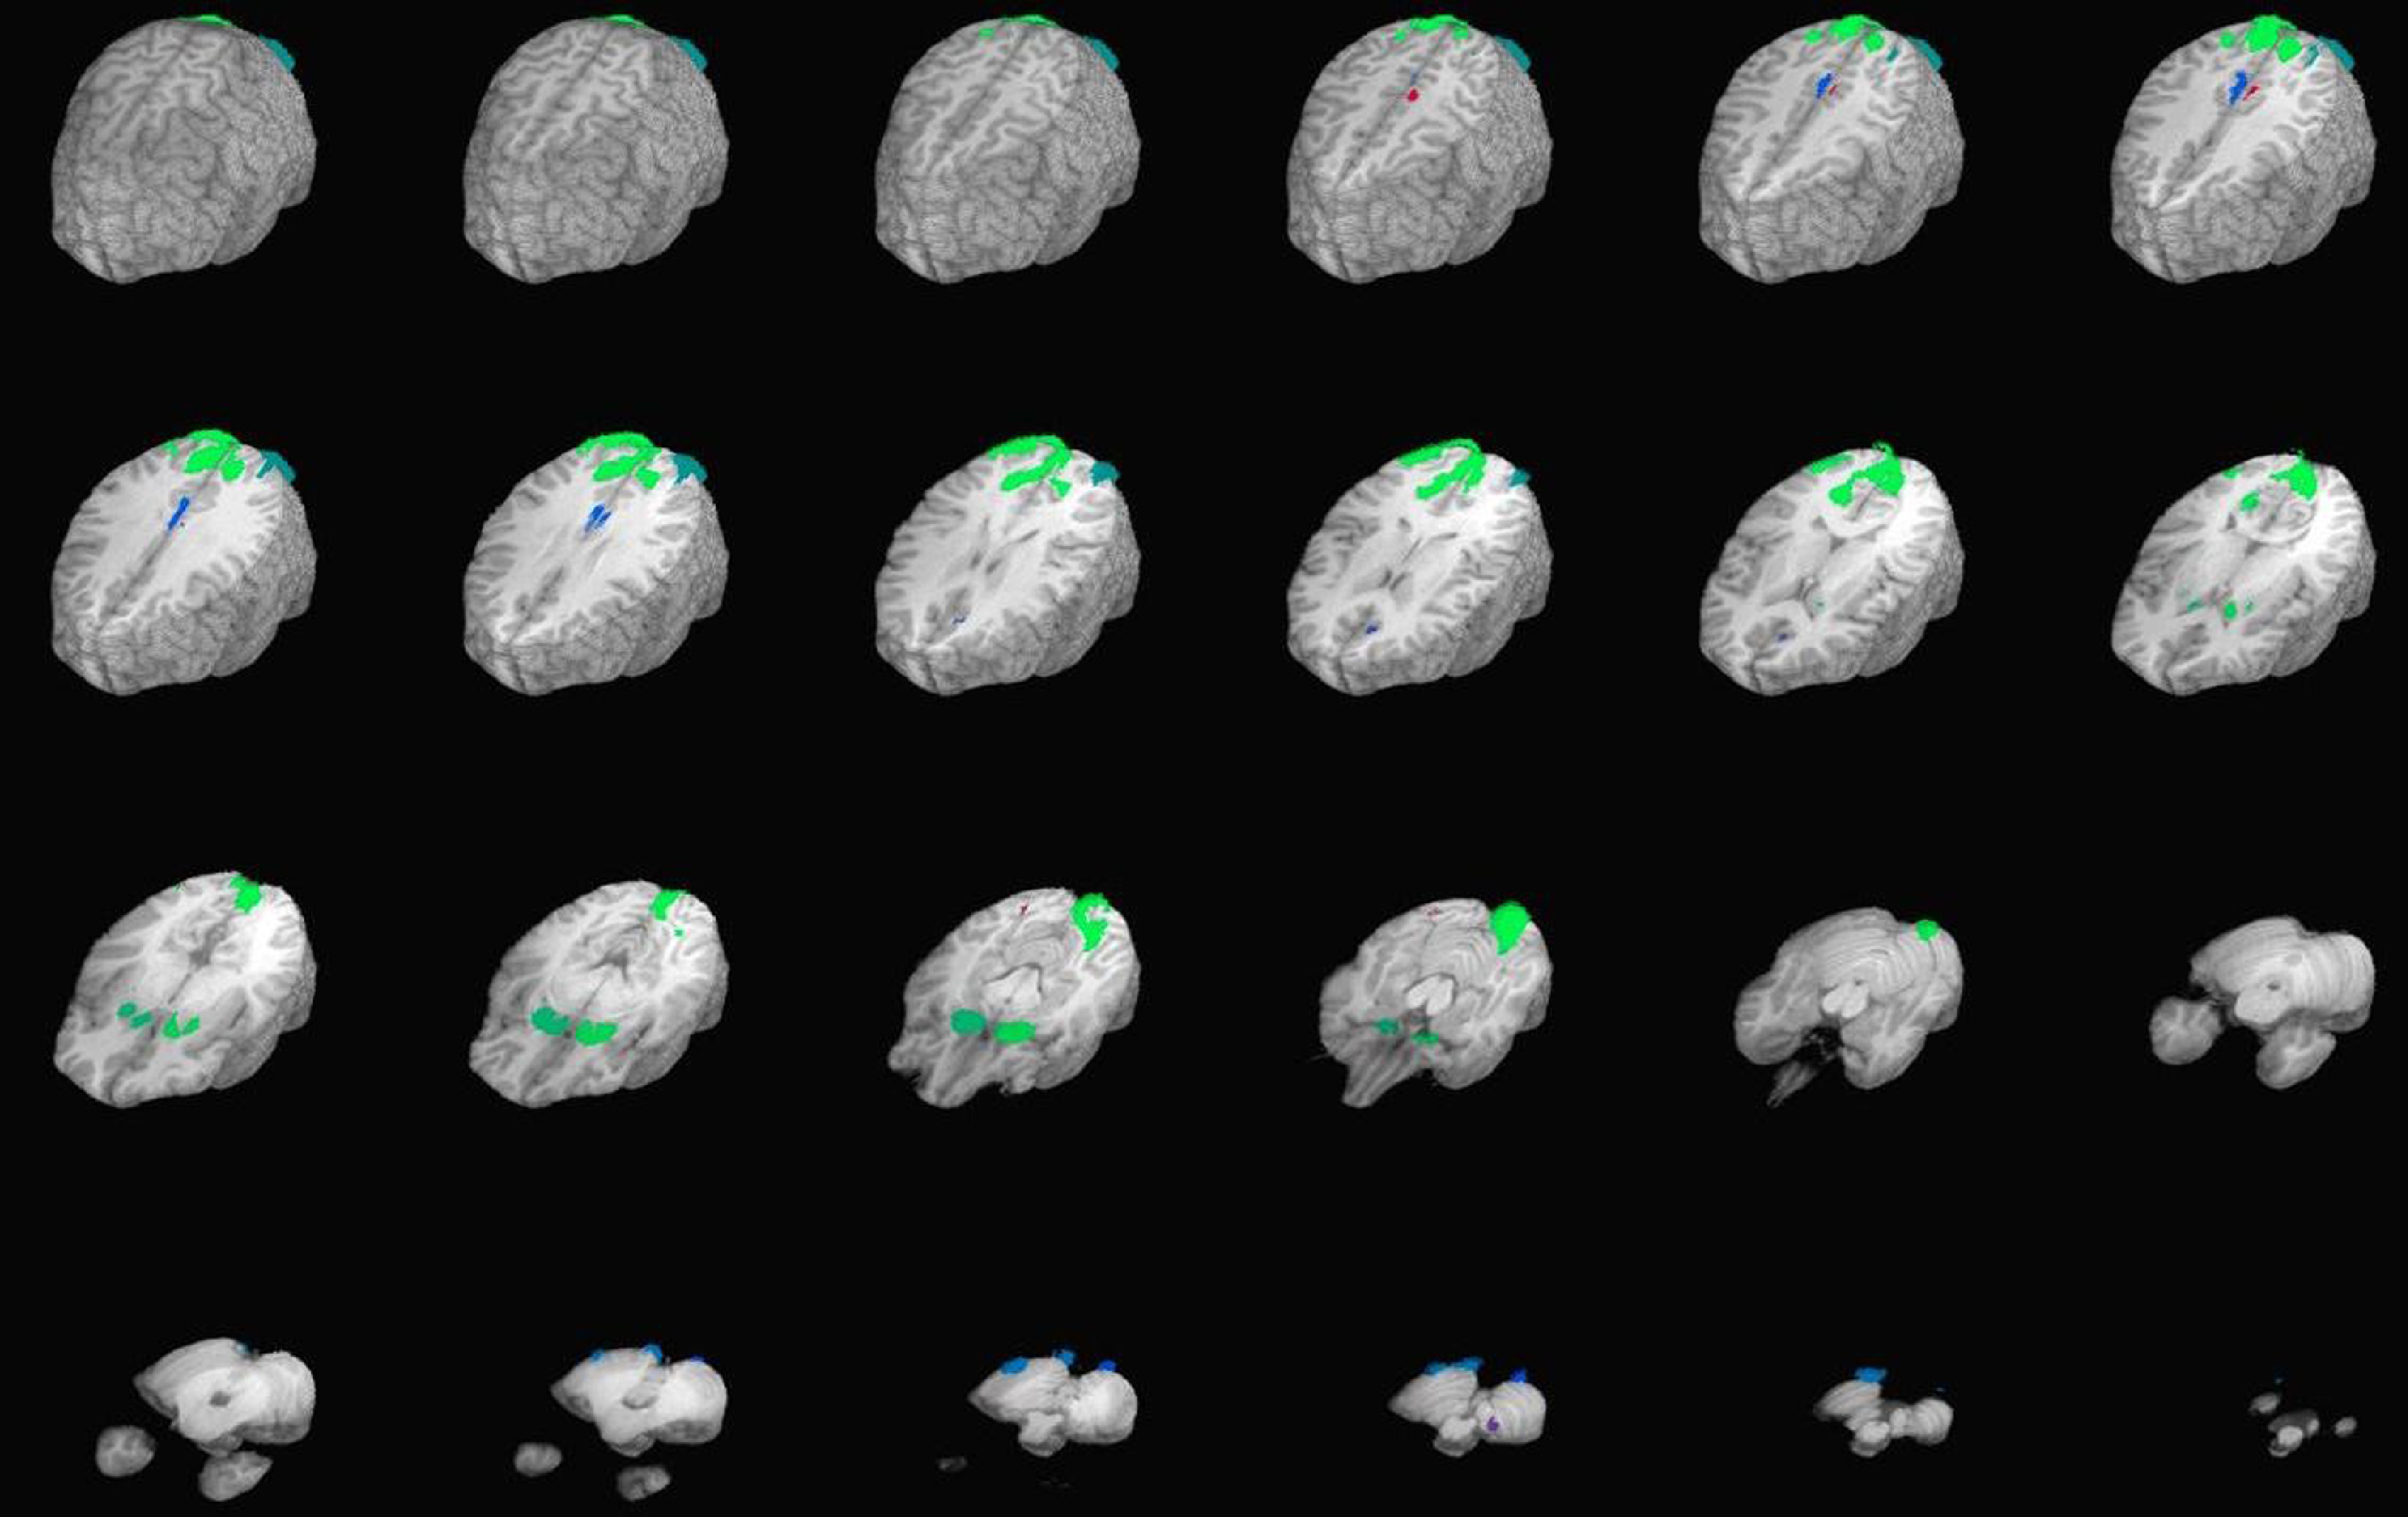
Empirically defined regions of interest from group-level activation of wins vs. losses.Note: Regions of interest exhibited significant activity during the win conditions on the gambling task compared to losses; Talairach Z-plane coordinates = +60 to −5-mm slices; thresholded to uncorrected p = 1−45